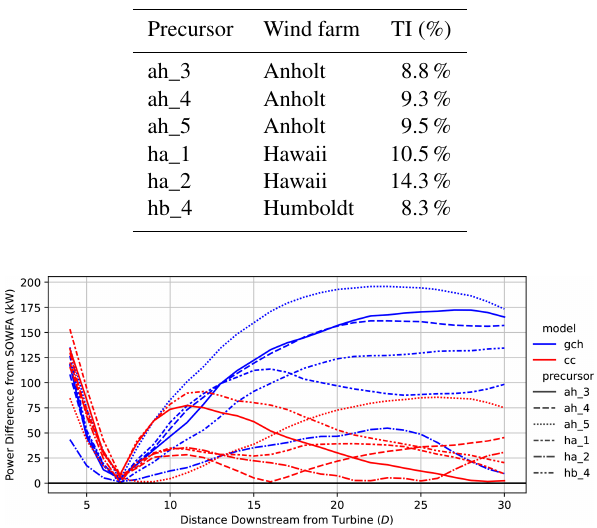
Table 2. Summary of the tuned turbulence intensity (TI) values used in the FLORIS simulations.